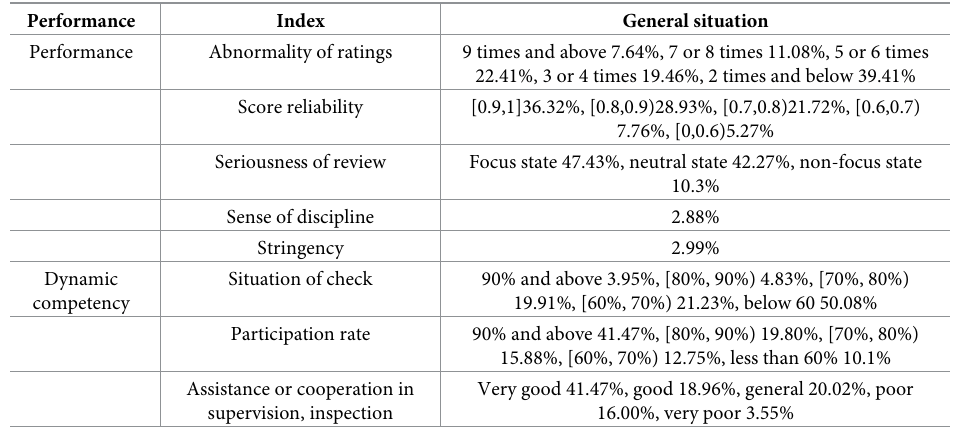
Table 4. Characteristics of performance.